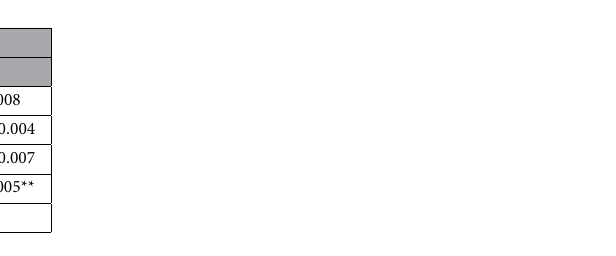
Table 4. Linear regression models for hs-CRP concentration by sex. *p < 0.01; **p < 0.001.